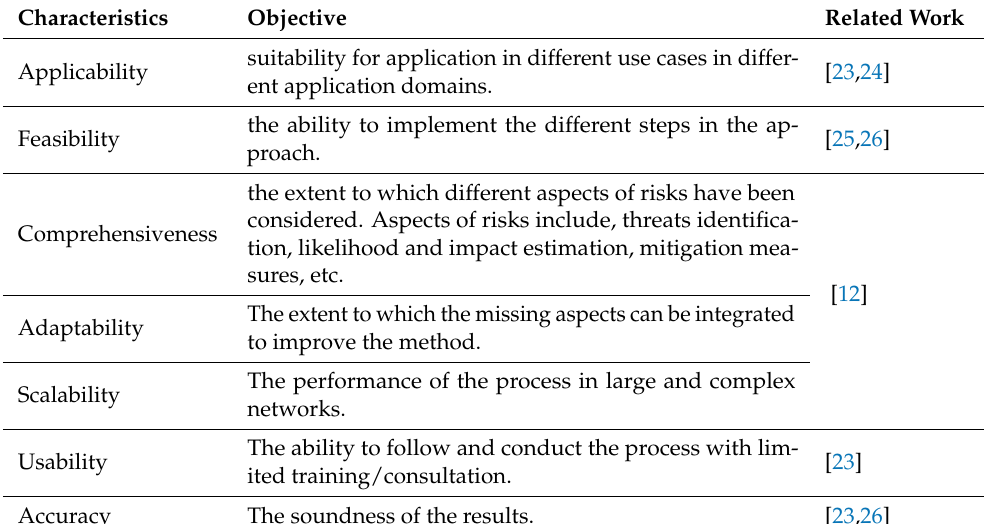
Table 1. Evaluation characteristics for the cyber risk assessment